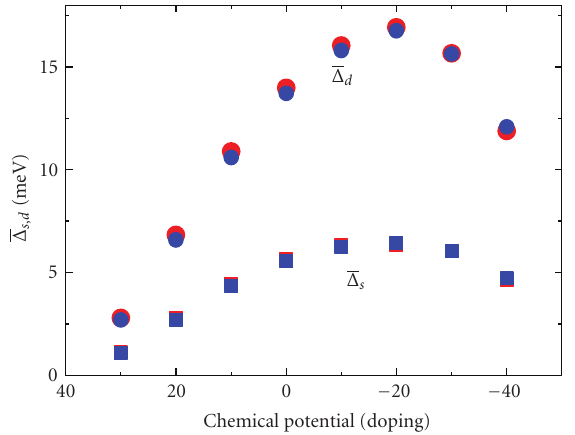
( T ) /λ 2 (0) as a ab ab